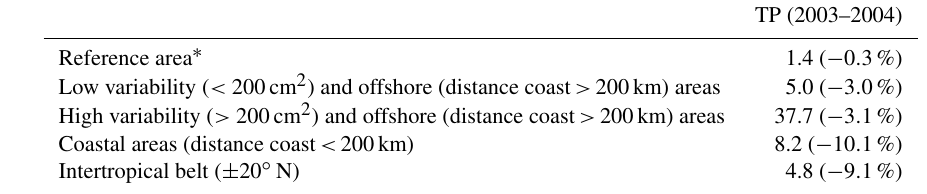
Table 3. Variance of the differences between gridded (L4) DT2018 two-satellite merged products and independent TP interleaved along-track measurements for different geographic selections (cm 2 ). In parentheses: variance reduction (%) compared with the results obtained with the DT2014 products. Statistics are presented for wavelengths ranging 65–500km and after latitude selection ( | LAT | < 60 ◦ ).